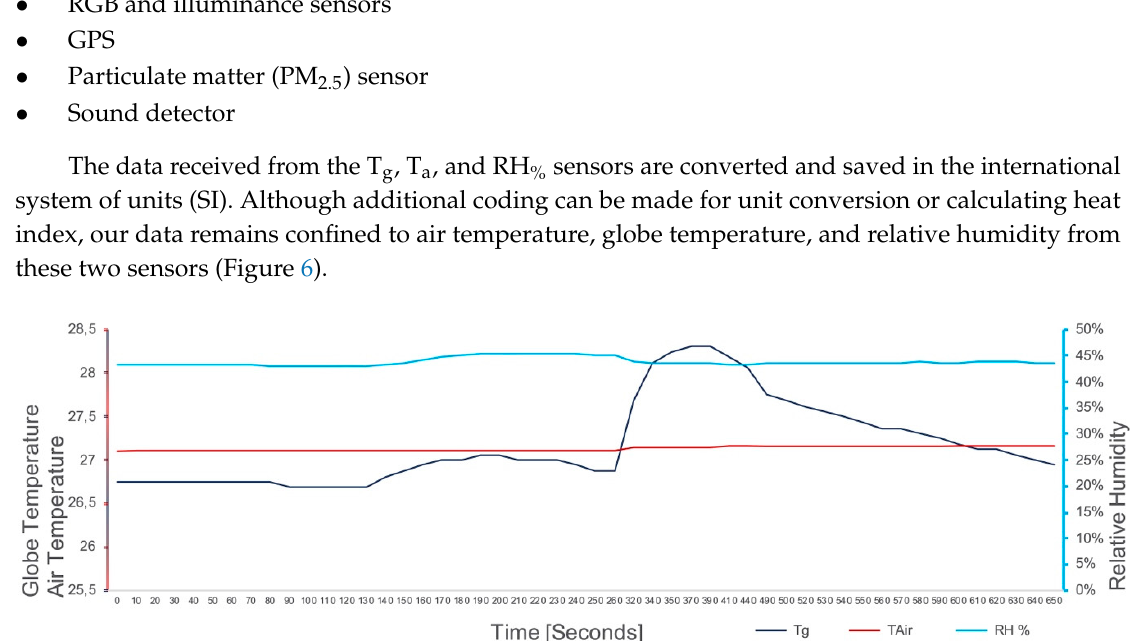
Figure 5 . An outline of data acquisition system.